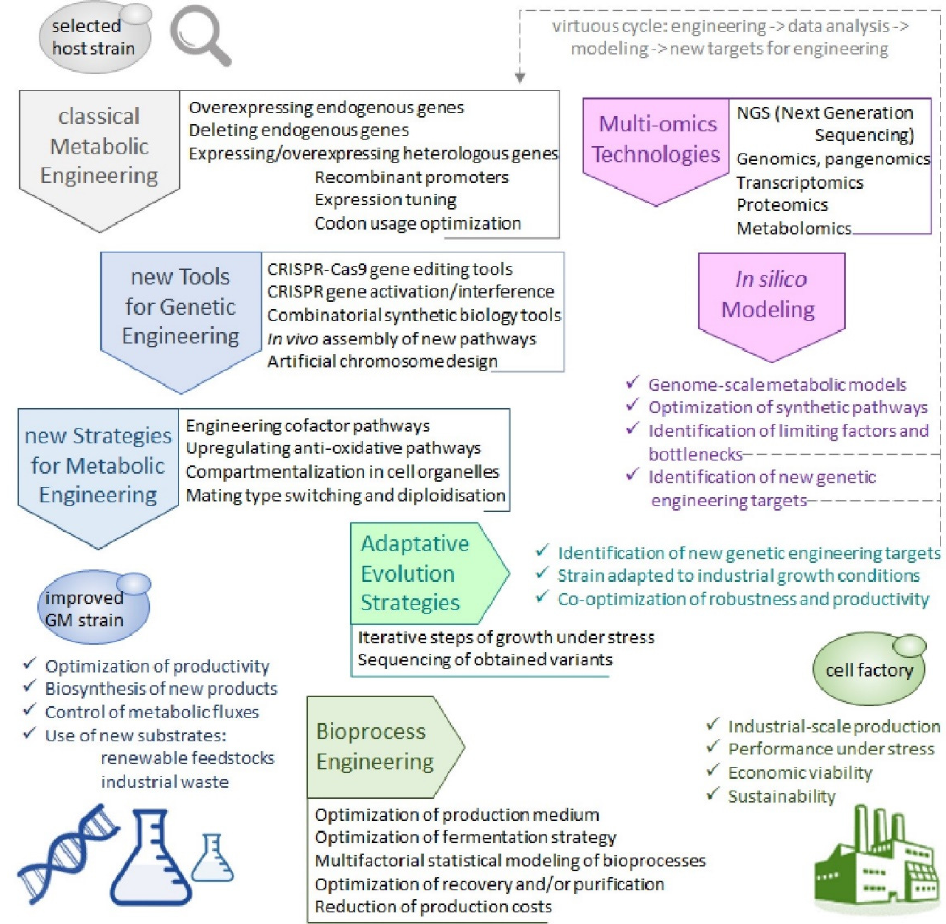
Figure 3. Schematic representation of the possible steps and available tools for engineering a Y. lipolytica strain into an effective cell factory. As explained in more detail in the text, both classical metabolic engineering methods and more re- cently developed tools, such as CRISPR-derived strategies, can be applied to remodelling metabolic pathways for produc- tion of a compound of interest. In addition, new strategies for metabolic engineering take also into account the availability of cofactors, the reduction of oxidative compounds and the compartmentalization of the modifications in different cell organelles, in a holistic view of the metabolic fluxes. The obtained GM (genetically modified) strain can also benefit of multi-omics technologies which, by allowing in silico modelling of genome-scale metabolic pathways, could contribute to identify limiting factors and bottlenecks, suggesting future genetic engineering targets in a virtuous circle. Adaptative evolution strategies could be employed to better adapt the GM strains to the stress of industrial growth conditions. At last, bioprocess engineering is required to develop viable and sustainable cell